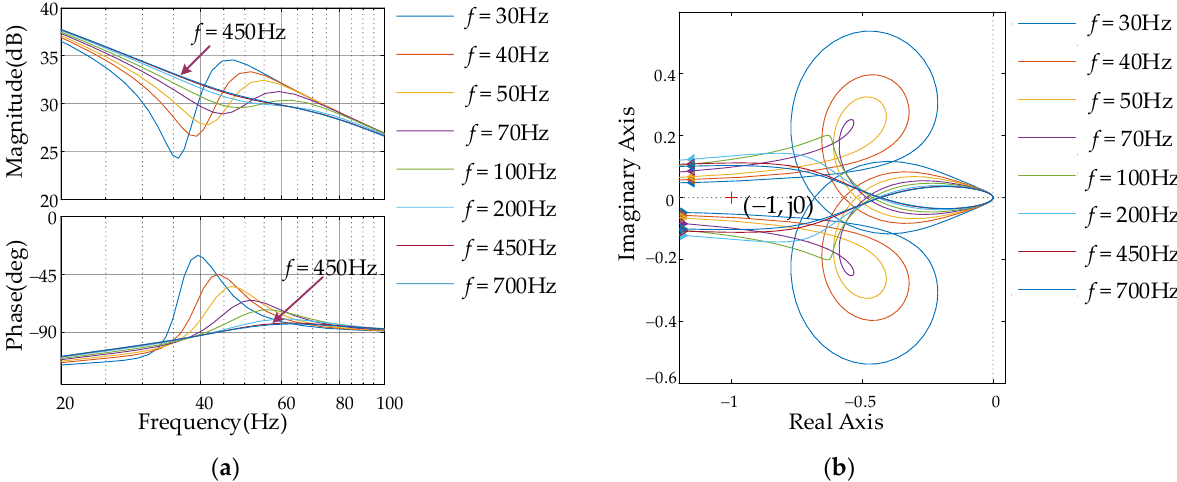
Figure 12. Stability analysis of the MVDC distribution system: ( a ) Bode diagram of (s) L_IPR Z , ( b ) Nyquist diagram of